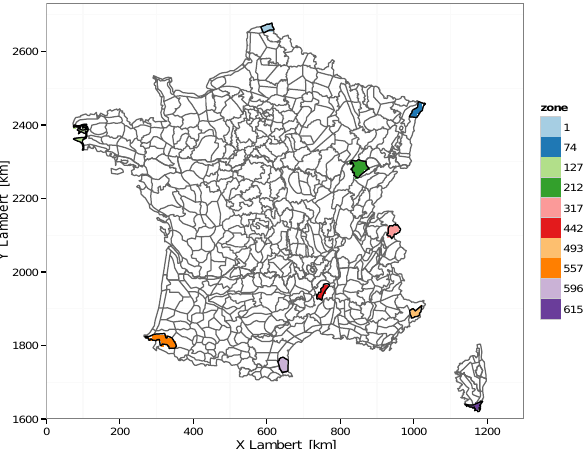
Fig. 1. The 608 climatologically homogeneous zones defined in the Safran data. The case study zones used in this study are coloured. The three zones situated in the Rhône catchment are Saône (212, dark green), Arve (317, light red) and Ardèche (442, dark red). The seven zones located at the geographical limits of the country are shown with other colours.